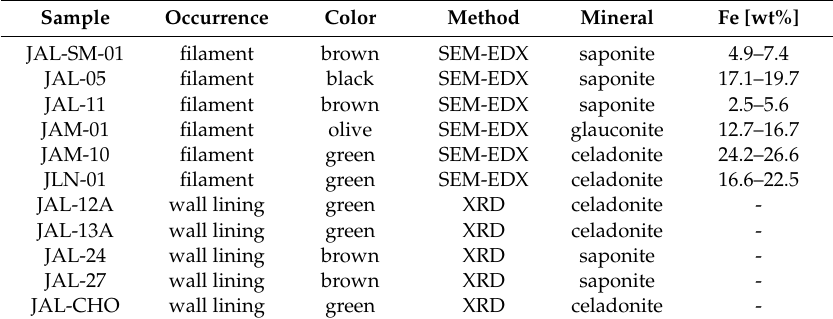
Table 4. Detected clay minerals in SFF and related Fe contents (SEM ‐ EDX analyses) and results of XRD analyses for wall ‐ lining clay minerals in different samples.